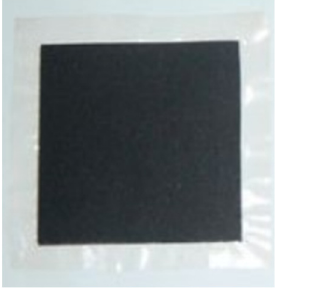
Figure 3. ( A ) Image of Ir-Pt-CCM of Nafion™ 117; ( B ) chemical structure of Nafion™ 117.